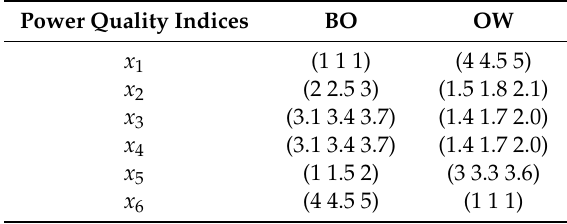
Table 6. The triangular fuzzy matrix of power quality index.